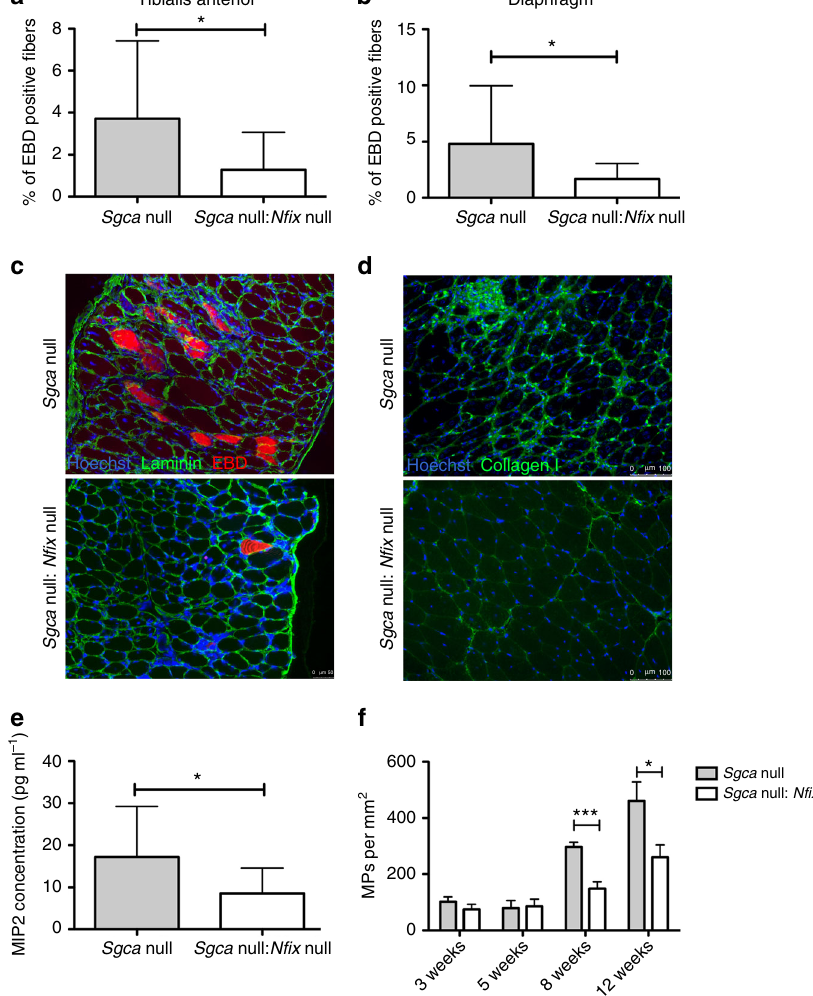
Fig. 3 Pathological parameters are rescued in dystrophic mice lacking N fi x. a Percentage of EBD positive myo fi bers in tibialis anterior muscles at 8 weeks; N = 19 Sgca null and 9 Sgca null: N fi x null mice; mean ± SD; t test, * P < 0.05. b Percentage of EBD positive myo fi bers in diaphragms at 8 weeks; N = 19 Sgca null and 11 Sgca null: N fi x null mice; mean ± SD; t test, * P < 0.05. c Immuno fl uorescence for laminin (green) and EBD (red) on diaphragms at 8 weeks. Hoechst (blue) stains nuclei. Scale bar 50 μ m. d Immuno fl uorescence showing collagen I (green) deposits in tibialis anterior sections. Scale bar 100 μ m. e MIP2 ELISA assay on gastrocnemius muscles at 8 weeks; N = 18 Sgca null and 7 Sgca null: N fi x null mice; mean ± SD; t test, * P < 0.05. f Quanti fi cation of the immuno fl uorescence staining for F4/80, marker of macrophages (MPs), on tibialis anterior muscle sections at different time points. N = 5 Sgca null and 5 Sgca null: N fi x null at 3 weeks, N = 3 Sgca null and 3 Sgca null: N fi x null at 5 weeks, N = 8 Sgca null and 8 Sgca null: N fi x null at 8 weeks, and N = 12 Sgca null and 7 Sgca null: N fi x null at 12 weeks. Mean ± SEM; t test, * P < 0.05, *** P <